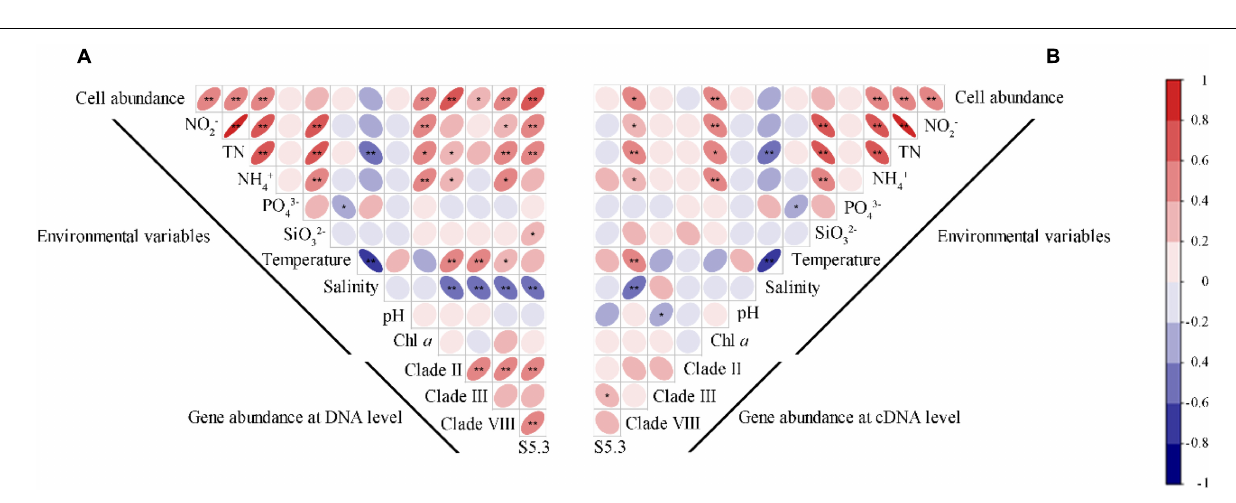
FIGURE 5 | Spearman correlations between the gene (A) and gene transcript (B) abundance of Synechococcus lineages with Synechococcus cell abundance and environmental variables. * – p < 0.05; ** – p <